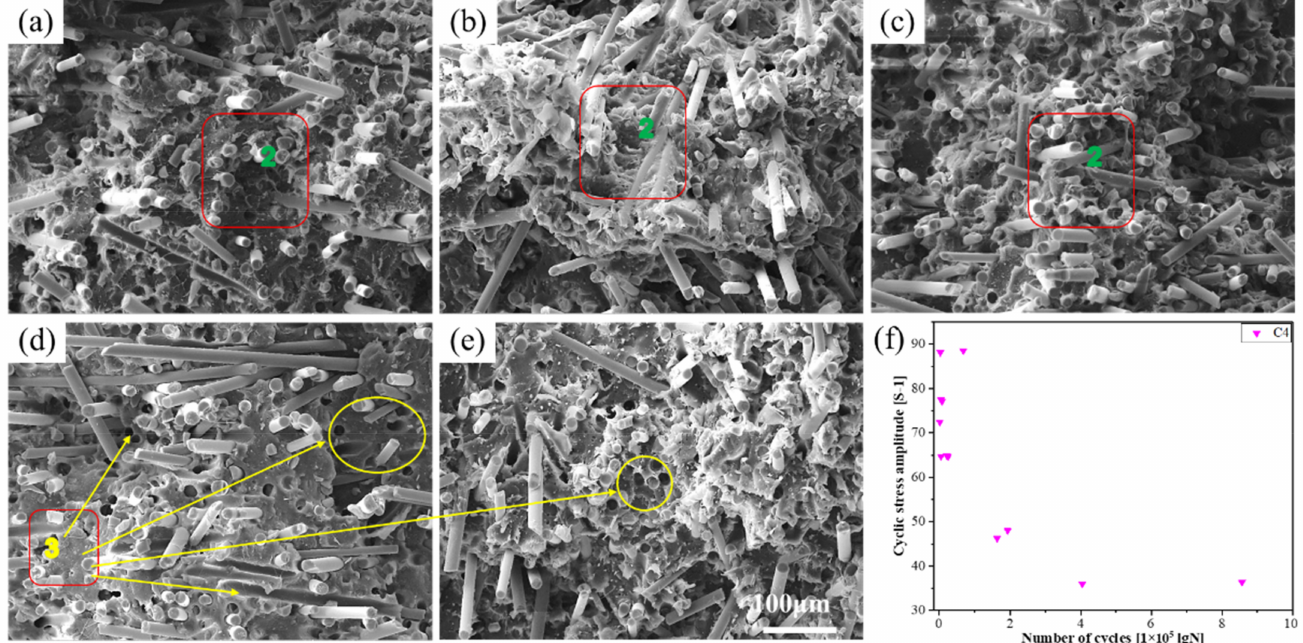
Figure 11. The fracture morphology and fatigue point of C4 at the following stress levels: ( a ) 30%, ( b ) 40%, ( c ) 55%, ( d ) 65%, and ( e ) 75%; and ( f ) fatigue point of C4 (area 2, fiber fracture; and area 3, fiber